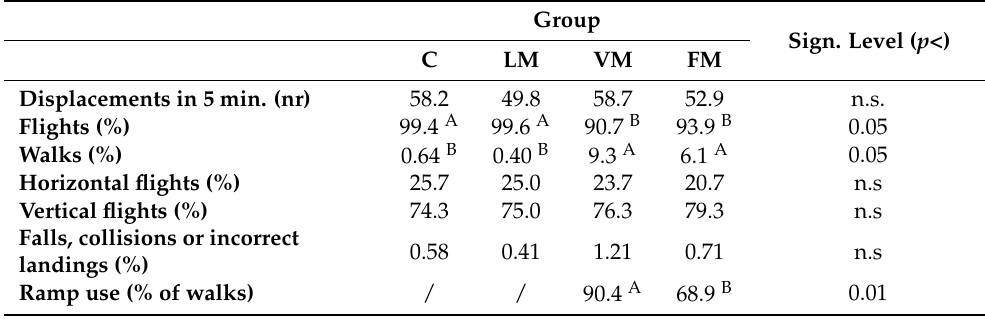
Table 5. Behavioural observations on the movements across the trial (2 replications per group) and at different times of the day. C = Control, LM = Longitudinal Movement, VM = Vertical Movement, FM = Freedom of Movement. (A, B: different superscripts on the same row indicate a statistically significant difference between